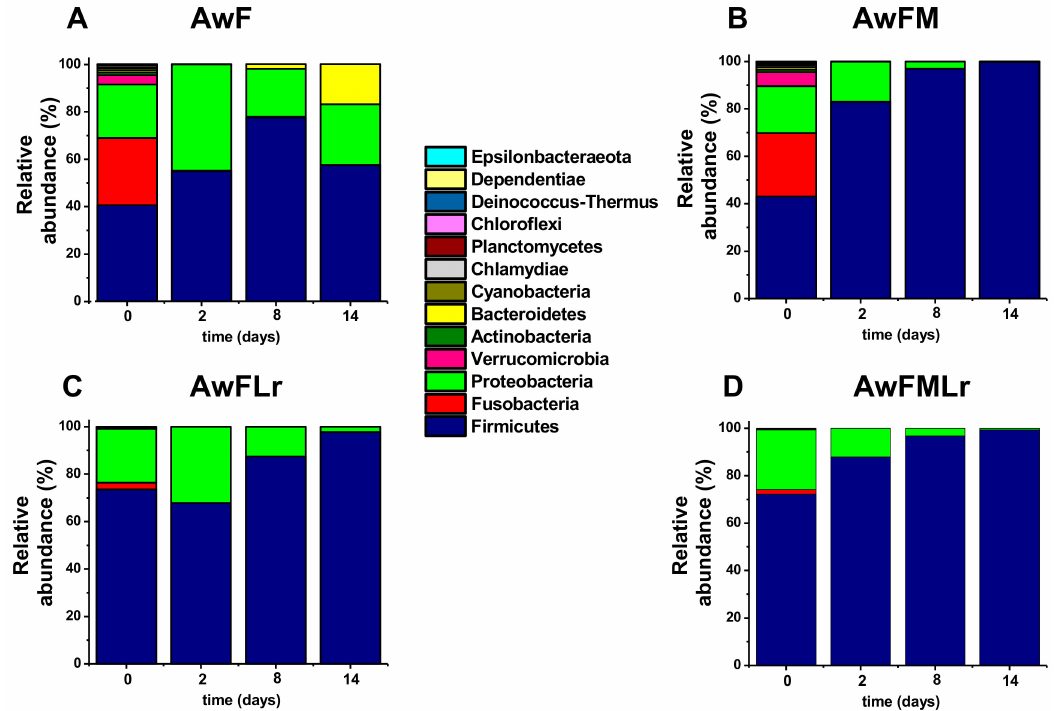
Figure 4. The relative abundance of the microbial community at the phylum level of the fermentation. ( A ) AwF; ( B ) AwFM; ( C ) AwFLr; ( D )